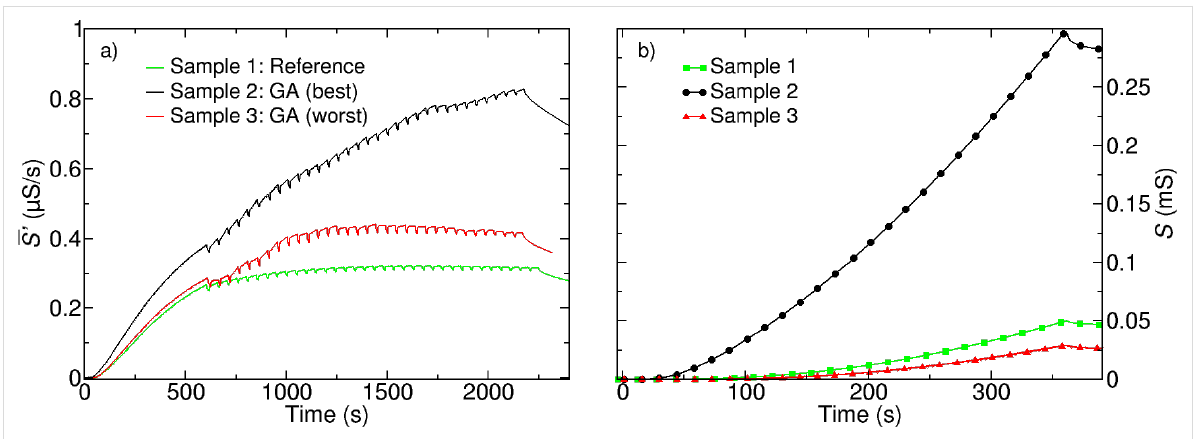
Figure 3: (a) Rate of change of conductance during the GA optimization for the W–C–O reference (green), GA-optimized deposit for highest conduc- tance (black) and GA-optimized deposit for lowest conductance (red). For each parameter set a dose of 3 nC/ μ m 2 was used. The population size amounted to 8 parameter sets and 6 optimization cycles, which were deposited for the GA optimization. (b) Conductance of A = 3 × 7 μ m 2 W–C–O structures deposited with parameters derived from the optimization processes in (a) as well as for the W–C–O reference when using a dose of 27 nC/ μ m 2